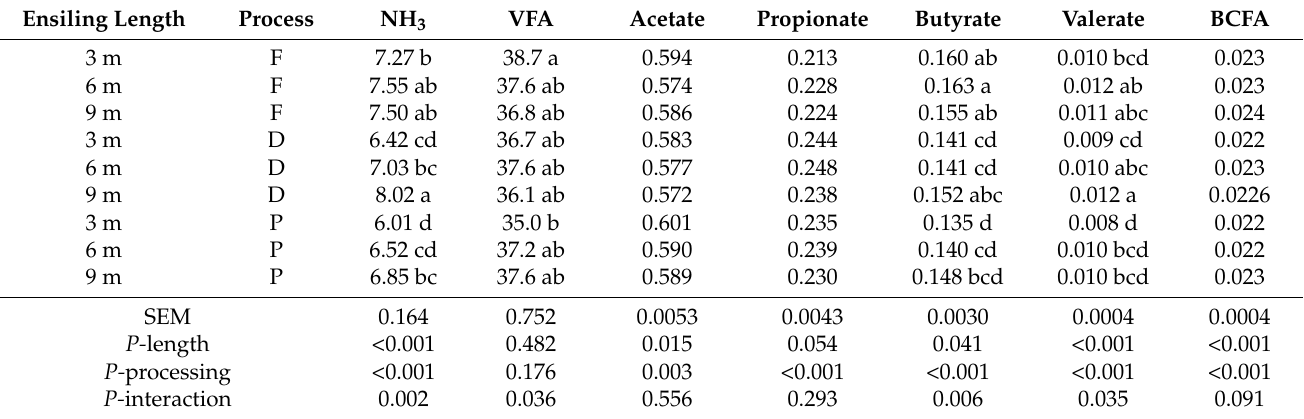
Table 5. Concentration of ammonia (NH 3 , mM) and volatile fatty acids (VFA, mM), and molar VFA proportions (mol/mol) after 12 h in vitro fermentation of silages opened after 3, 6, and 9 months, before (F) and after heat processing (dehydrated, D, or dehydrated and pelleted,